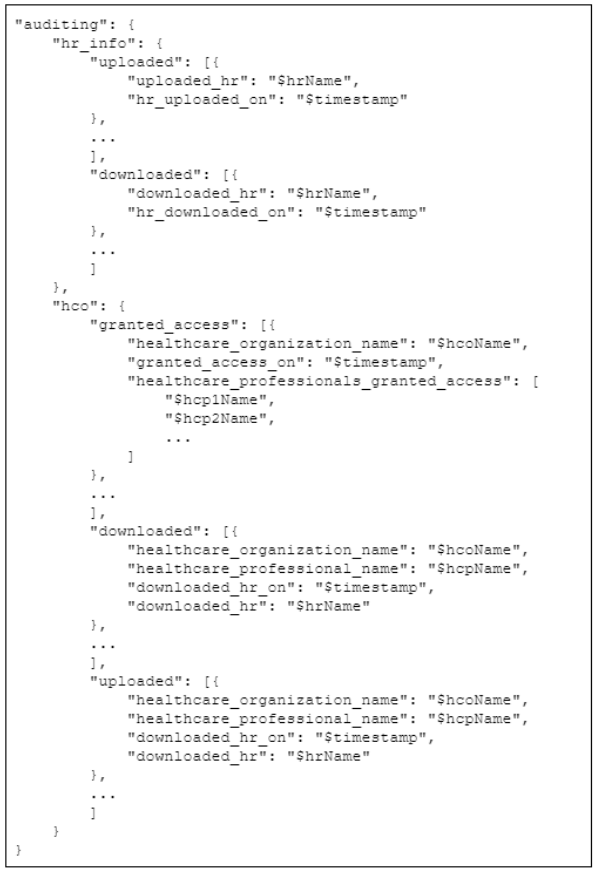
Figure 6. Auditing information kept by the Auditing Component that can be provided to the storage cloud’s users.